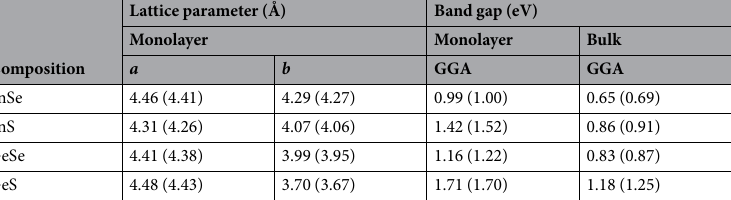
Lattice parameter (Å)